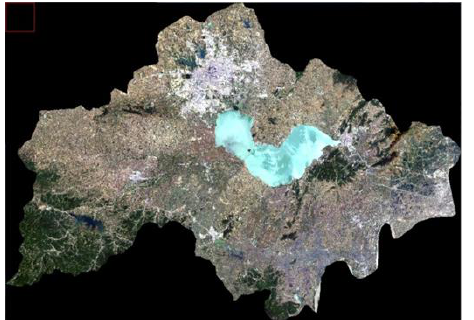
Figure 1. Research area of the Chaohu Lake basin (bands of